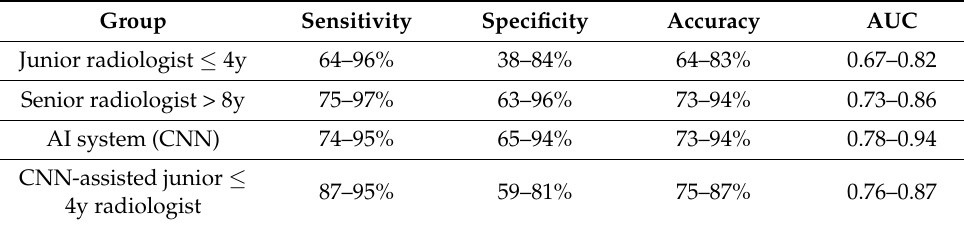
Table 1. Diagnostic performance of CNN-based AI and